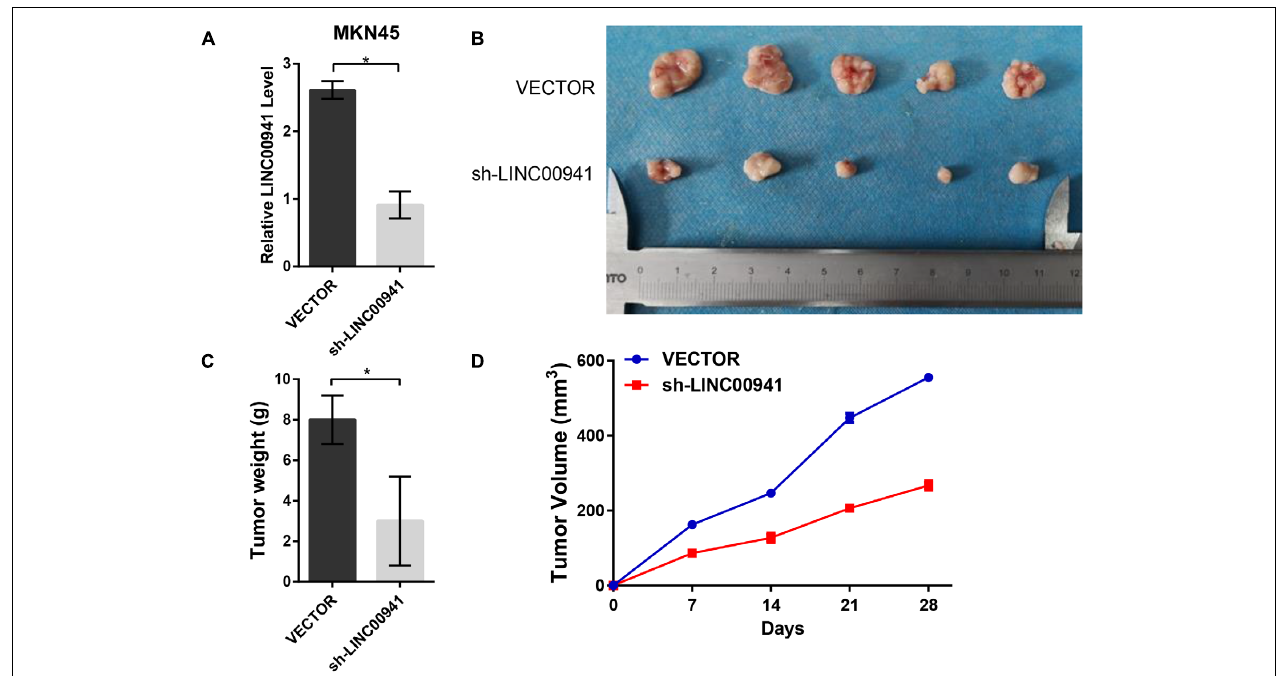
FIGURE 5 | Silence of LINC00941 suppresses tumor growth in vivo . (A) LINC00941 was knocked down by shRNA in MKN45 cells. (B) The tumors in sh-LINC00941-infected nude mice significantly smaller than the negative control. (C) Tumor weights in nude mice with sh-LINC00941-infected were significantly lighter than the negative control. (D) Tumor volumes in nude mice with sh-LINC00941-infected significantly smaller than the negative control. Two-tailed Student’s t -test was used to analyze the significant differences, ∗ p < 0.05.